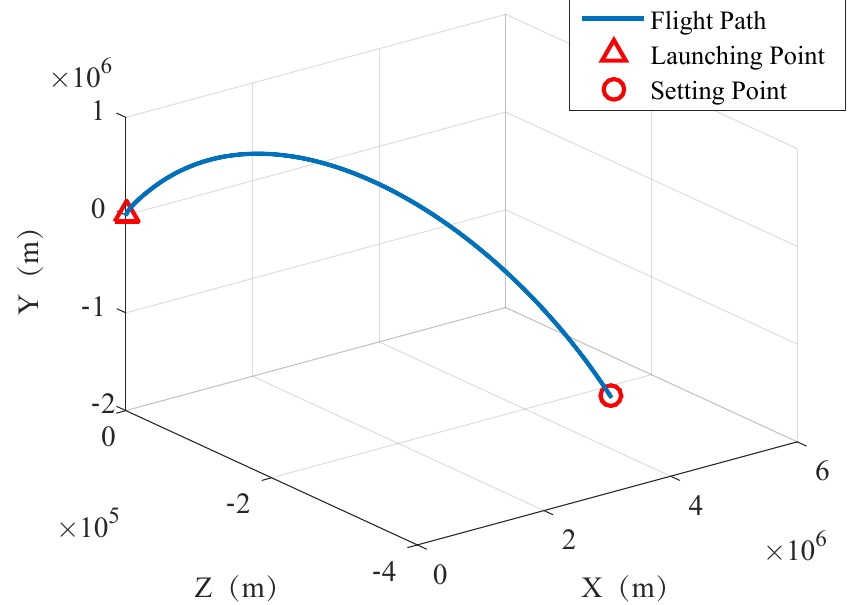
Figure 9. Partial 3D trajectory of the aircraft in the flight area.